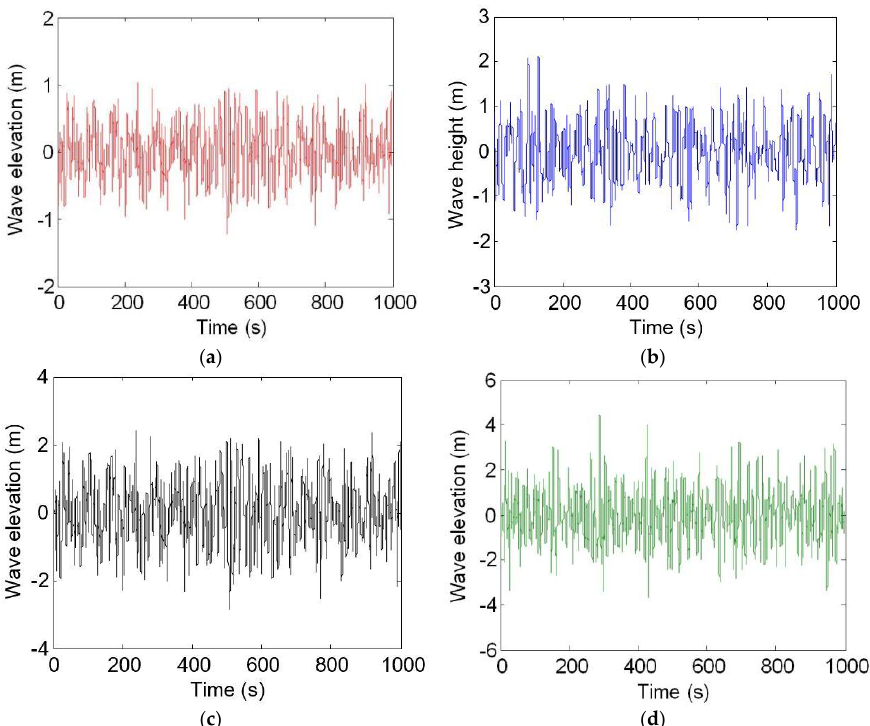
Figure 12. Wave elevation graphs for random waves with equal peak frequency and significant wave height values of ( a ) 1.5 m; ( b ) 2.5 m; ( c ) 3.5 m; ( d ); 4.5 m.